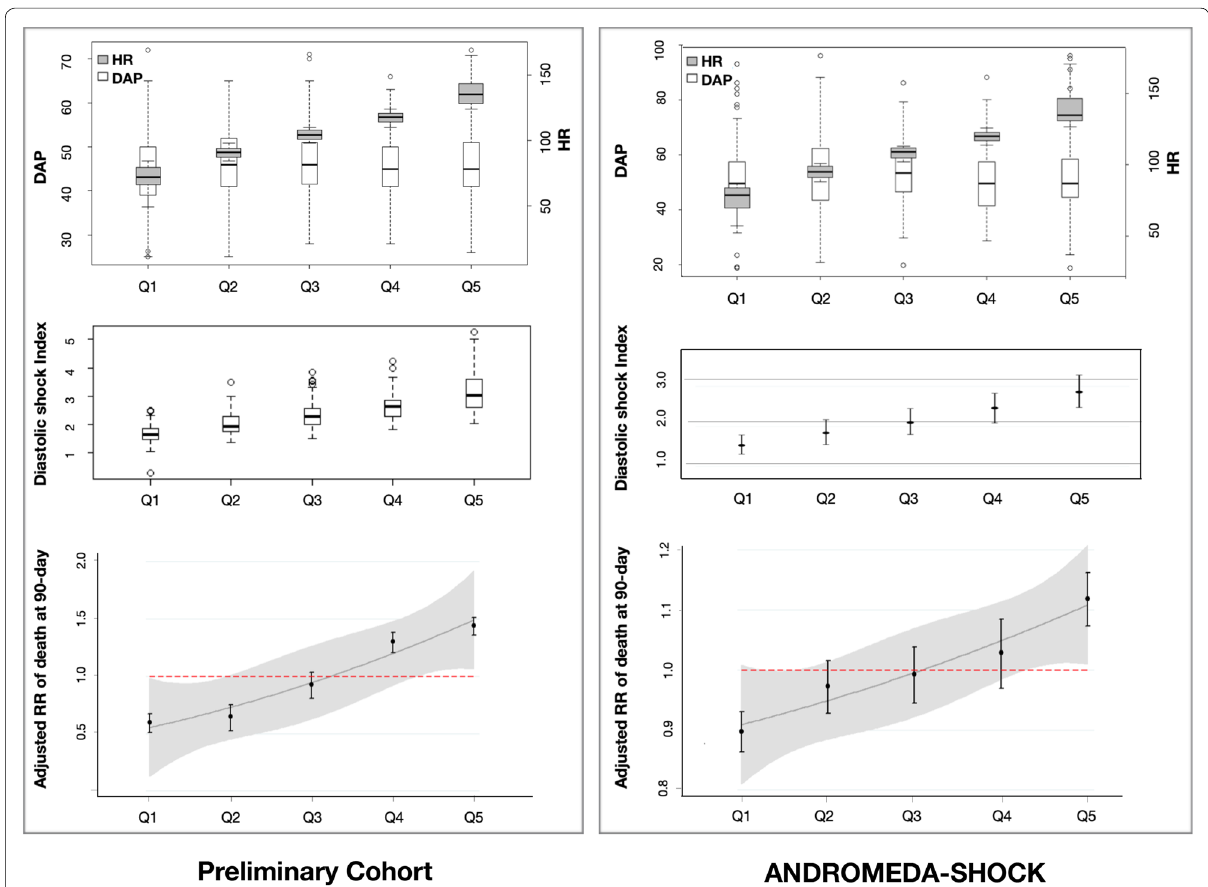
Fig. 3 Relative risk of death at day‑28 according to heart rate (HR) partition the preliminary and ANDROMEDA SHOCK populations. Heart rate (HR) values from just before the start of vasopressor support were partitioned into 5 quantiles (Q1 to Q5). Distribution of heart rate (HR) and diastolic pressure (DAP) (top) displays a progressive increasing of HR values through the quantile partitioning with their corresponding DAP values, which remains similar from Q1 to Q5. The respective diastolic shock index distribution (middle) is presented through the quantile distribution. The boxes (top) delineate the interquartile range, the median is shown as a line in the middle of the box, and tails represent the 95% range. Boxplots/error bars (middle) represent medians and 95% confidence intervals of the diastolic shock index (DSI) at each quantile. Relative risks’ distributions (bottom) were calculated as described in Fig. 1. Note that adjusted relative risk of death increases as HR and subsequently DSI also increases, for similar